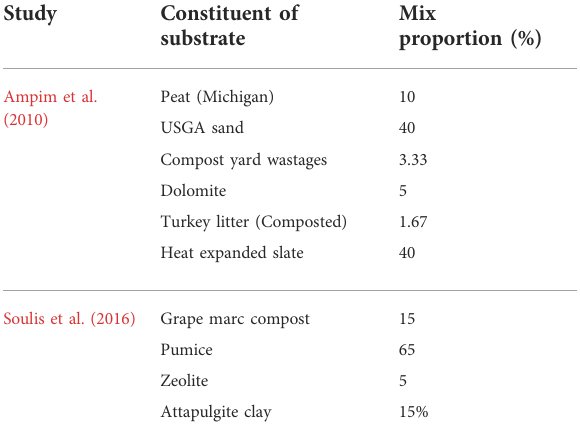
TABLE 1 Substrate proportions with respective compositions considered in past studies.